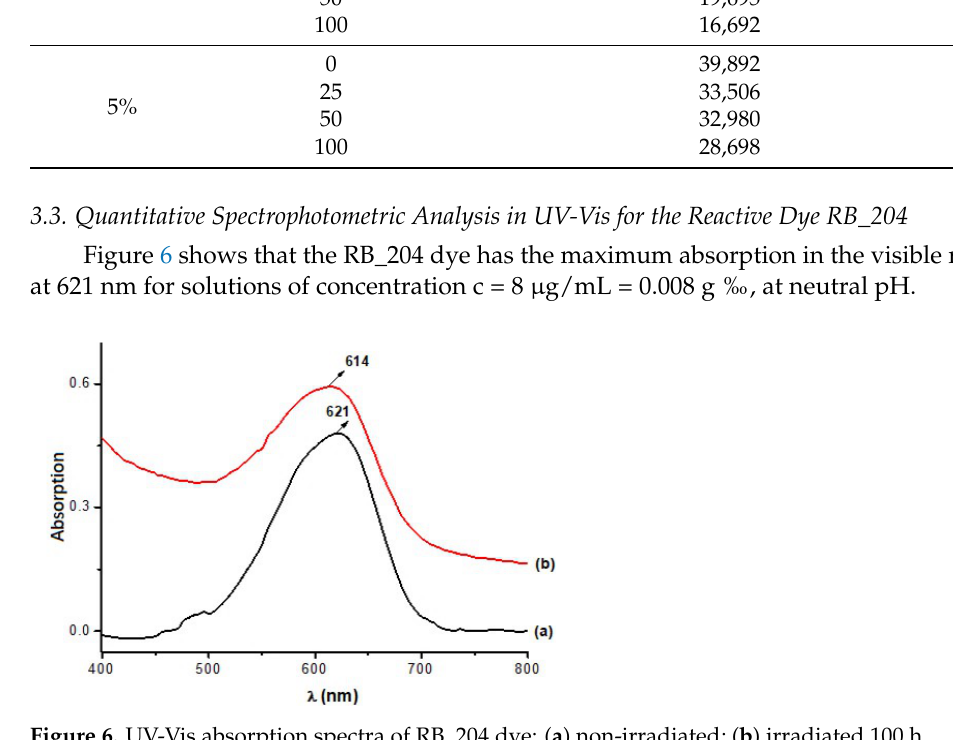
Figure 6. UV-Vis absorption spectra of RB_204 dye: ( a ) non-irradiated; ( b ) irradiated 100 h. The reduction of absorption (hypochromic effect) and the bathocrom displacement of the peak towards higher wavelength values (from 614 to 621 nm) was